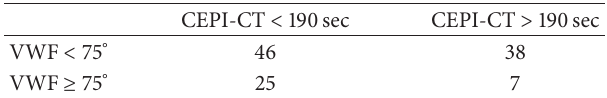
Table 4: Negative predictive value of CEPI-CT > 190sec for VWF > 75 ∘ percentile.